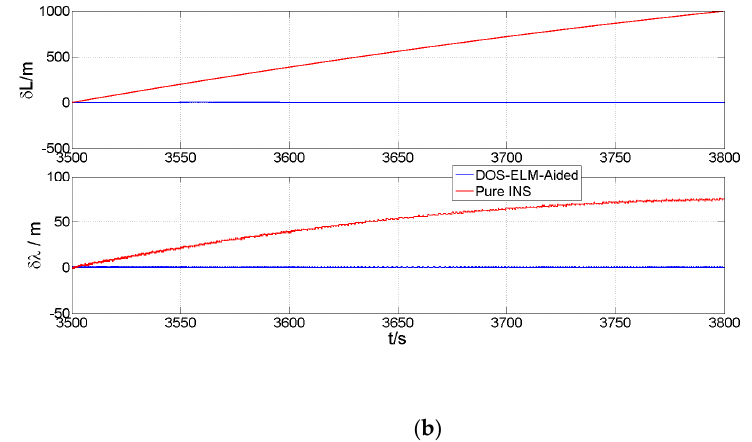
Figure 8. Comparison of speed/position errors between DOS-ELM-aided and pure INS methods during GPS outage #1 in the vehicle-mounted experiment. ( a ) Eastern and northern speed errors of DOS-ELM-aided and pure INS methods during GPS outage #1 in the vehicle-mounted experiment. ( b ) Eastern and northern position errors of DOS-ELM-aided and pure INS methods during GPS outage #1 in the vehicle-mounted experiment.